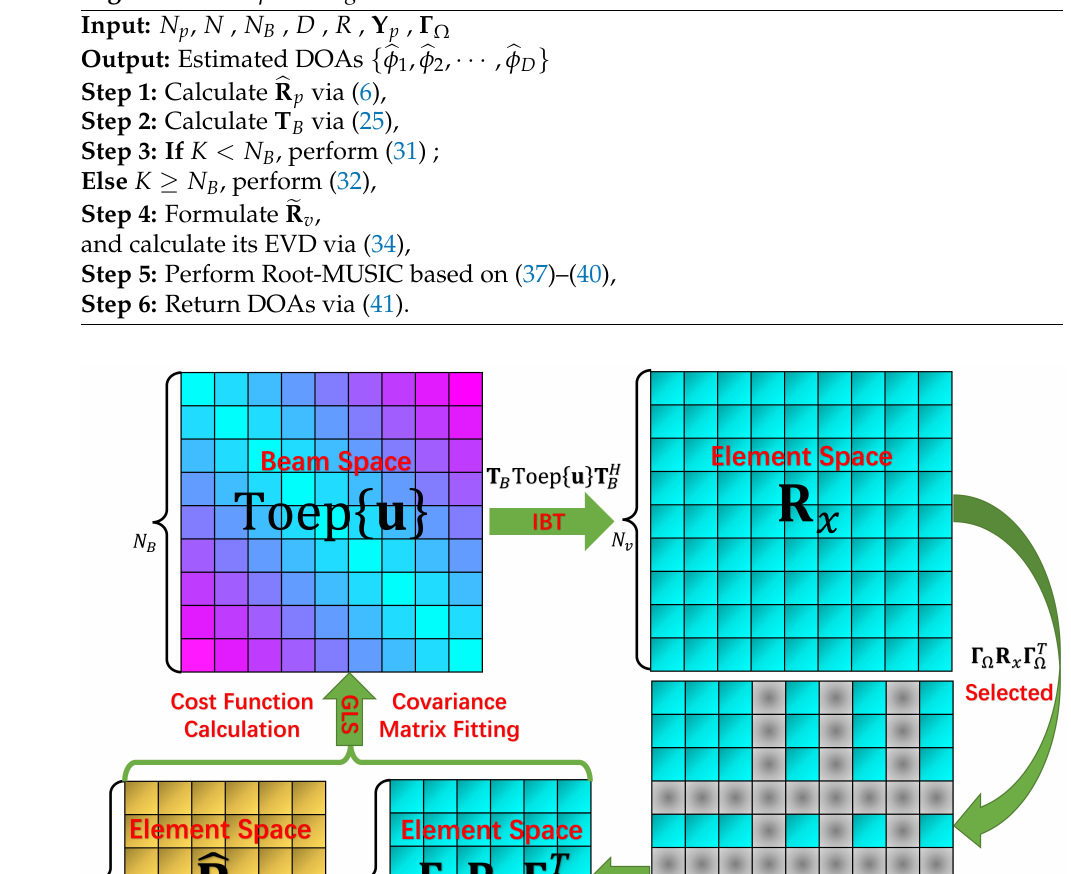
Algorithm 1 Proposed Algorithm : GSCA